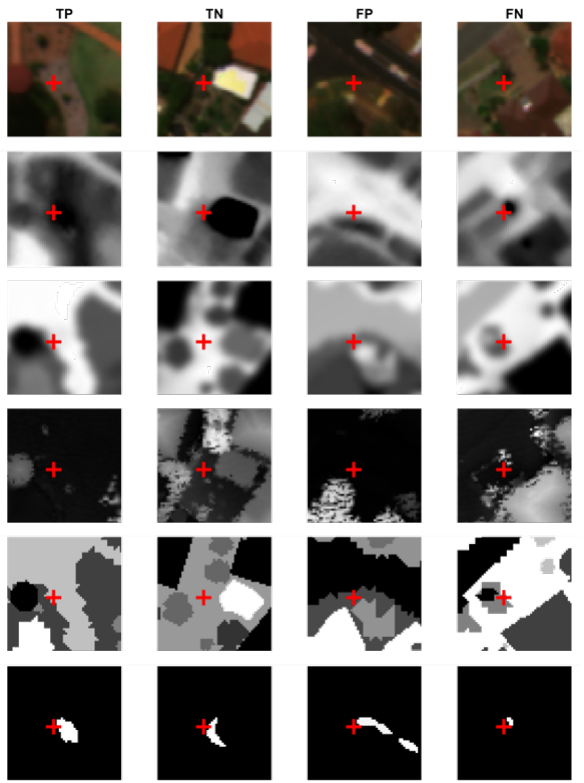
Figure 5. Examples of the test data. From left to right: correctly classified anomaly (true positive, TP), correctly classified explainable area (true negative, TN), falsely classified anomaly (false positive, FP), falsely classified explainable area (false negative, FN). The rows show the corresponding image section of the region-of-interest, from top to bottom: orthophoto, measured thermal image, simulated thermal image, NDSM, class image, binary mask of the region.